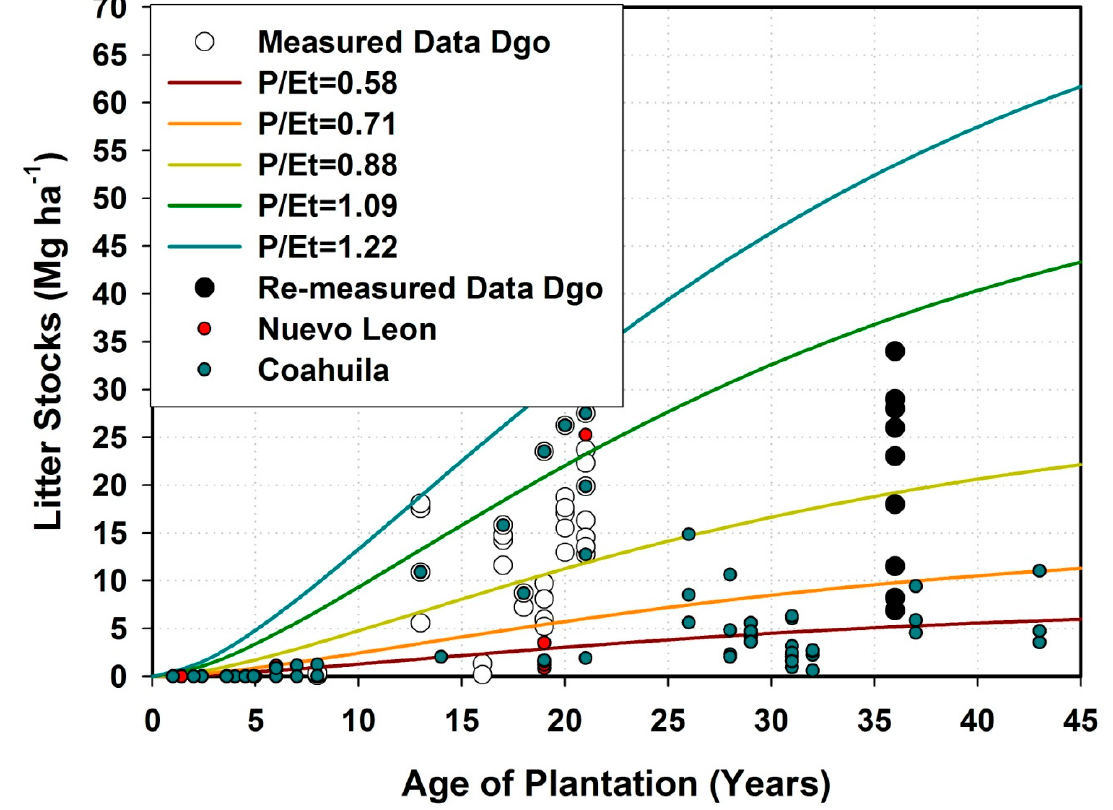
Figure 4. The statistical, SM LS , model for evaluating litter stocks and accumulation rates for non- industrial planted forests of northern